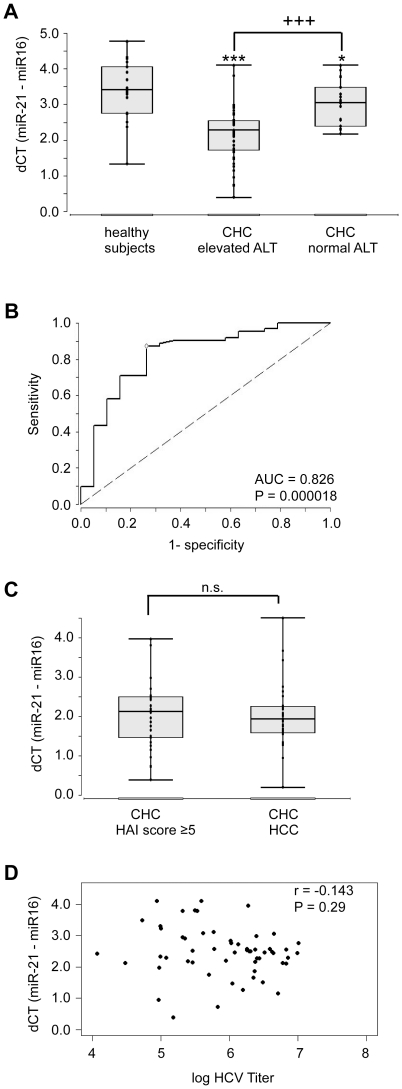
Increased serum miR-21 concentrations in patients with CHC and elevated levels of ALT.(A), dCT values of miR-21 of sera from healthy control individuals (n = 19), patients with CHC and elevated serum ALT levels (n = 44) and CHC patients with normal serum ALT levels (n = 18). Boxes represent range, median and quartiles of the number of threshold cycles (CT) required to detect miR-21 by real-time RT-qPCR normalized to CT of miR-16. Differences were calculated with Wilcoxon-Mann-Whitney-U-test. *P<.05, ***P<.001, compared with the healthy control group. +++
P<.001 between CHC patients with normal or elevated ALT. (B), ROC curve analysis of serum miR-21 concentration for discriminating CHC patients and healthy controls. (C), dCT values of CHC patients with elevated ALT and HAI≥5 (n = 31) and patients with CHC and HCC (n = 29) showing no significant difference in miR-21 levels (Wilcoxon-Mann-Whitney-U-test: P>.3) between both groups, n. s. = not significant. (D) Relationship between serum miR-21 levels and the serum HCV RNA in patients with CHC. The relation is not significant (P = .29).